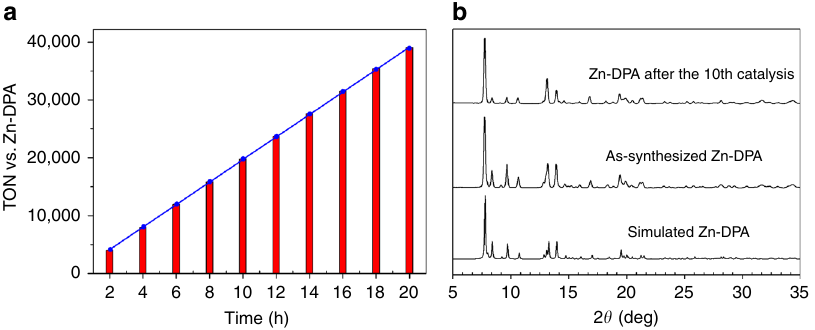
Fig. 3 Reusability of catalyst Zn-DPA. a Time-course and recycling CO 2 fi xation experiments with Zn -DPA under standard conditions. b PXRD patterns of simulated Zn -DPA (bottom), synthesized Zn -PDA (middle), and Zn -PDA after 10 successive times of the CO 2 fi xation reaction with 2-(phenoxymethyl) oxirane